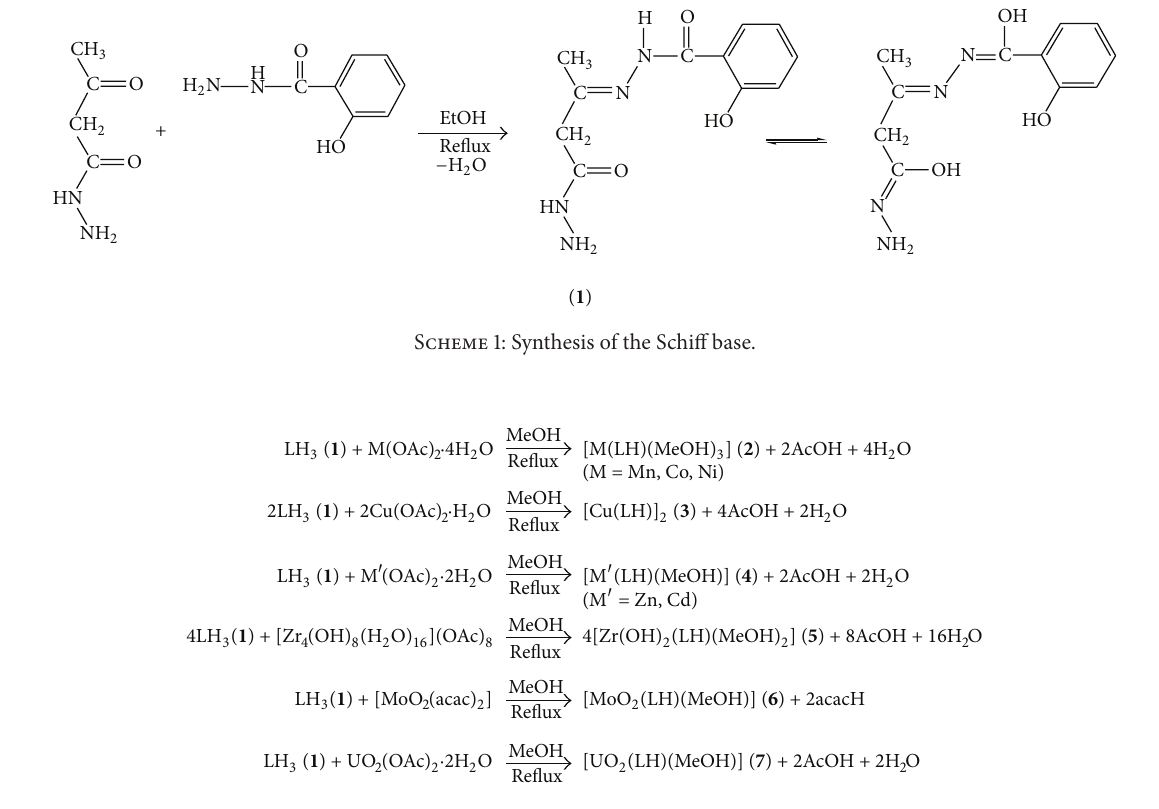
Scheme 2: Synthesis of complexes 2 - 7